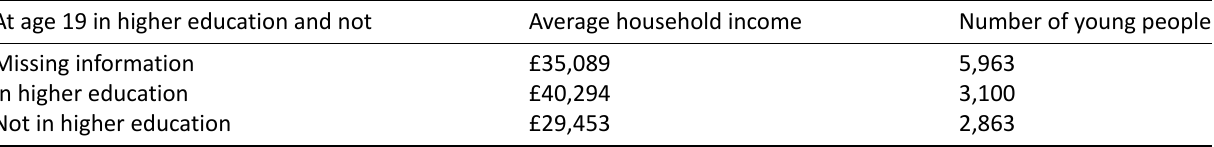
Table 6. Average household income and higher education admission